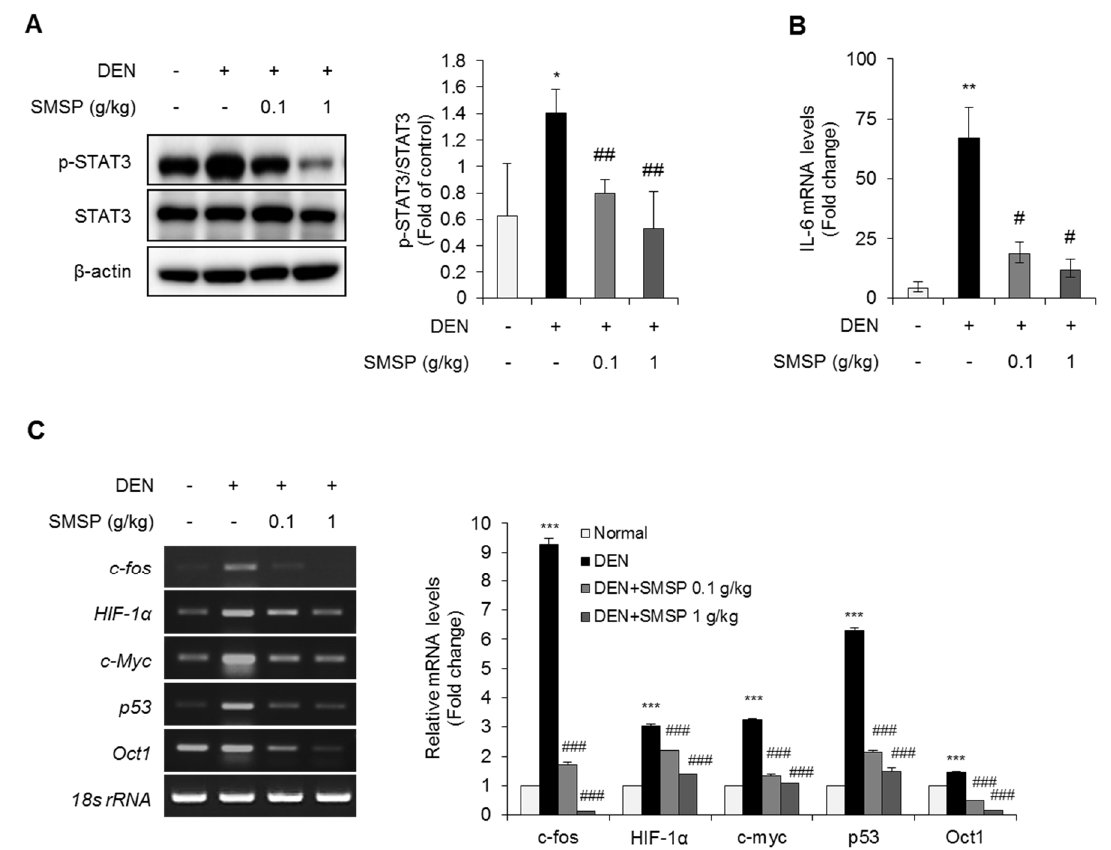
Figure 6. SMSP inhibits signal transducer and activator of transcription 3 (STAT3) phosphorylation and related signaling in rats treated with DEN for 16 weeks. ( A ) Hepatic protein levels of p-STAT3 and STAT3 were determined by immunoblotting. The level of p-STAT3 relative to control group was quantified. ( B ) Hepatic IL-6 mRNA level was measured by qRT-PCR. IL-6 mRNA levels were normalized relative to Rn18S . ( C ) Hepatic mRNA levels of STAT3-target genes, c-fos , HIF-1 α , c-Myc , p53 , and Oct1 were measured by RT-PCR. Quantification of mRNA expressions relative to control group was exhibited. All mRNA levels were normalized relative to Rn18S . Results are presented as the mean ± SD. Statistical significance was analyzed by ANOVA. * p < 0.05, ** p < 0.01, and *** p < 0.001 compared to control; # p < 0.05, ## p < 0.01, and ### p < 0.001 compared to the DEN group.